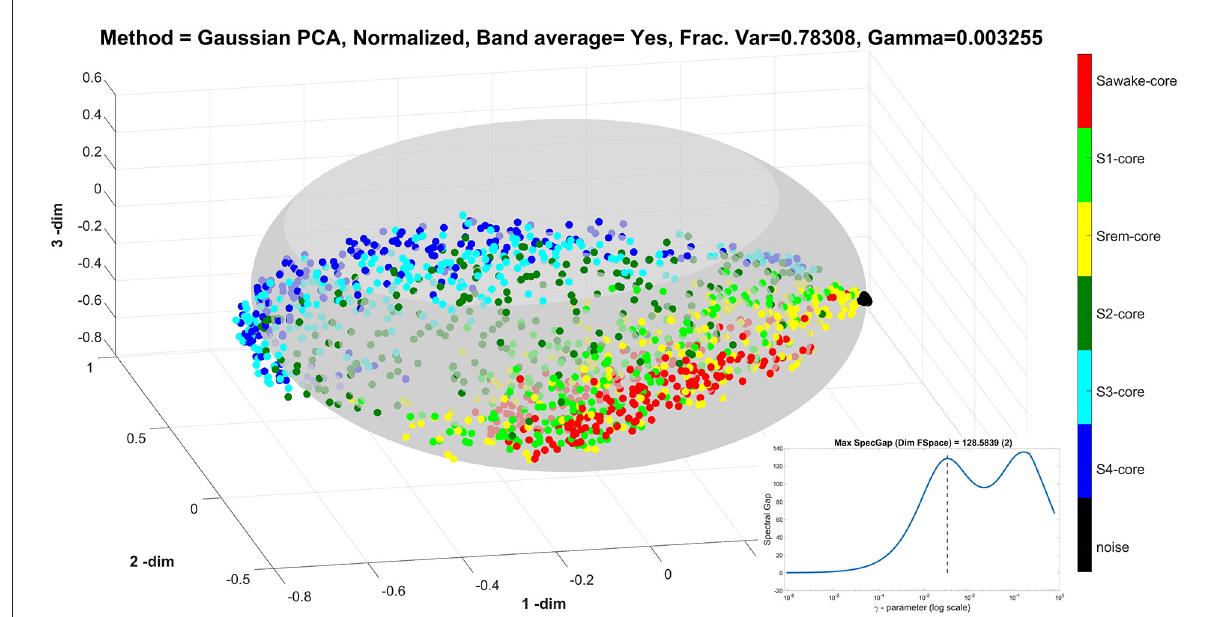
FIGURE5 The results of Gaussian Kernel PCA analysis using the un-united ROI resolution in the 3D space defined by the first three PCA. There are over one and a half thousand nodes which are now labeled according to the category each one belongs (noise, ECW, and the five sleep stages). The insert shows the spectral gap as a function of the γ -parameter value in a semi-log scale, which has two peaks. The display shows the results using the value of γ at the first peak, marked by the dash vertical line in the insert (at γ = 0.00326). With this choice of γ , the nodes from the noise measurement collapse to almost a point which serves as the origin of the representation since it represents the region of feature space with very small values. The nodes corresponding to measurements with the subject in place are well-spread forming a good representation of the underlying